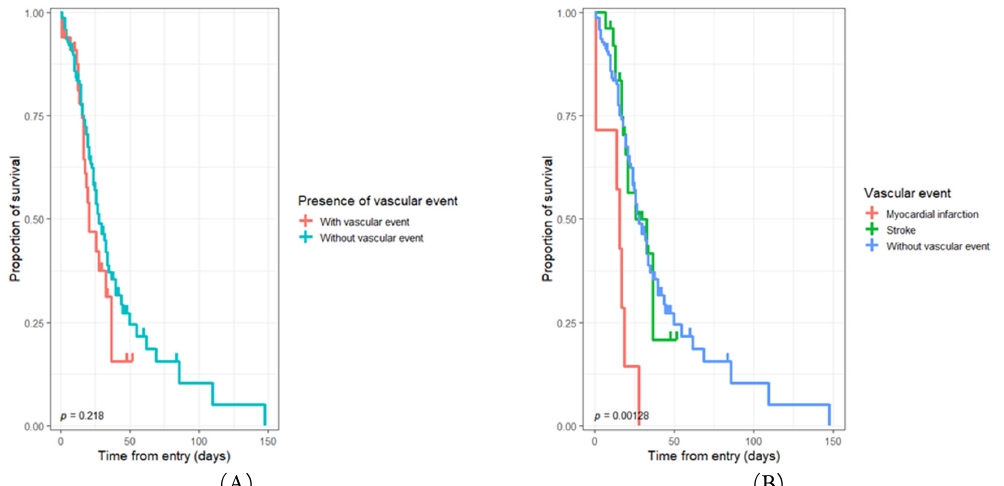
Figure 2. Survival during hospitalization period regarding the presence (A) and the type (B) of vascular event